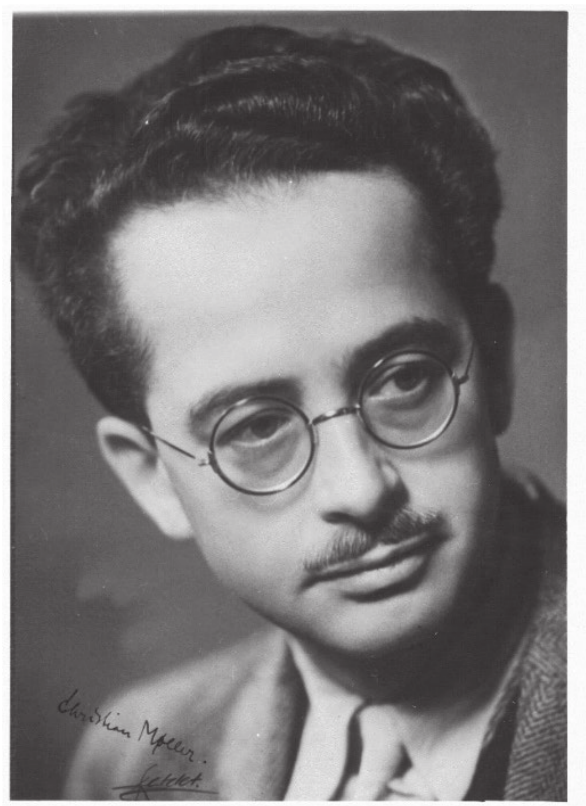
Figure 1. Portrait photography of Christian Møller, 1936. Credit: Niels Bohr Archive, Photo Collection,